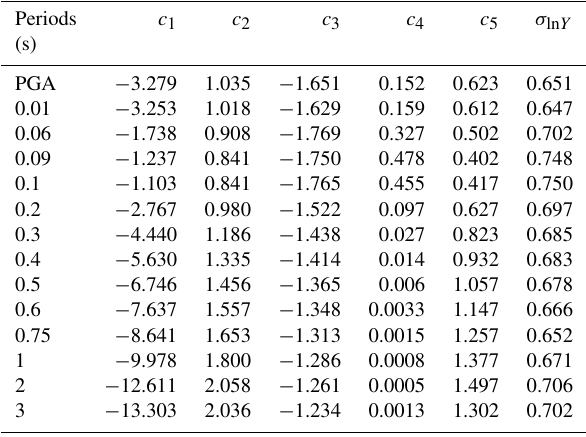
Table 2. Summary of the coefficients of the local ground-motion models used in this study (Lin et al.,